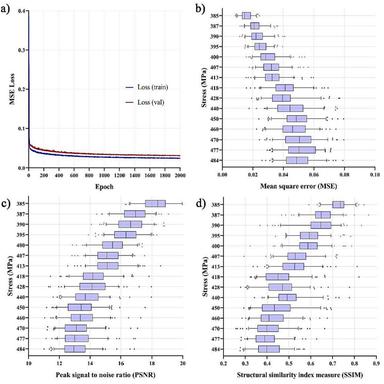
Model performance for predicting the next 15 frames based on an input sequence of 10 consecutive frames. (a) the changing trend of training and validation loss; (b)-(d) box-whisker plots of MSE, PSNR, and SSIM.